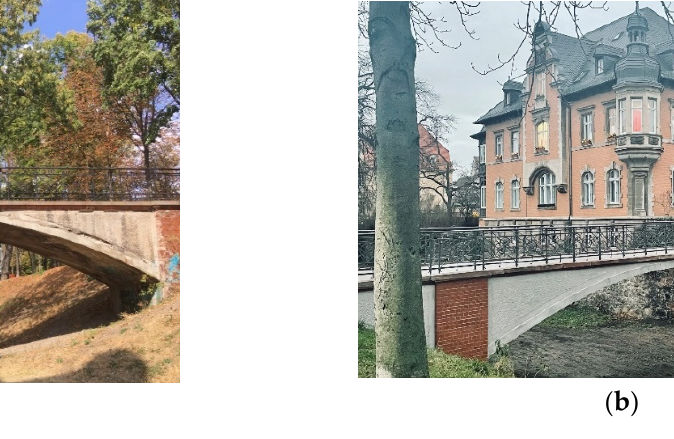
Figure 8. View of the historical arch bridge Thainburg: ( a ) before strengthening; ( b ) after the strengthening with carbon reinforced concrete. (Photos: CARBOCON GMBH).